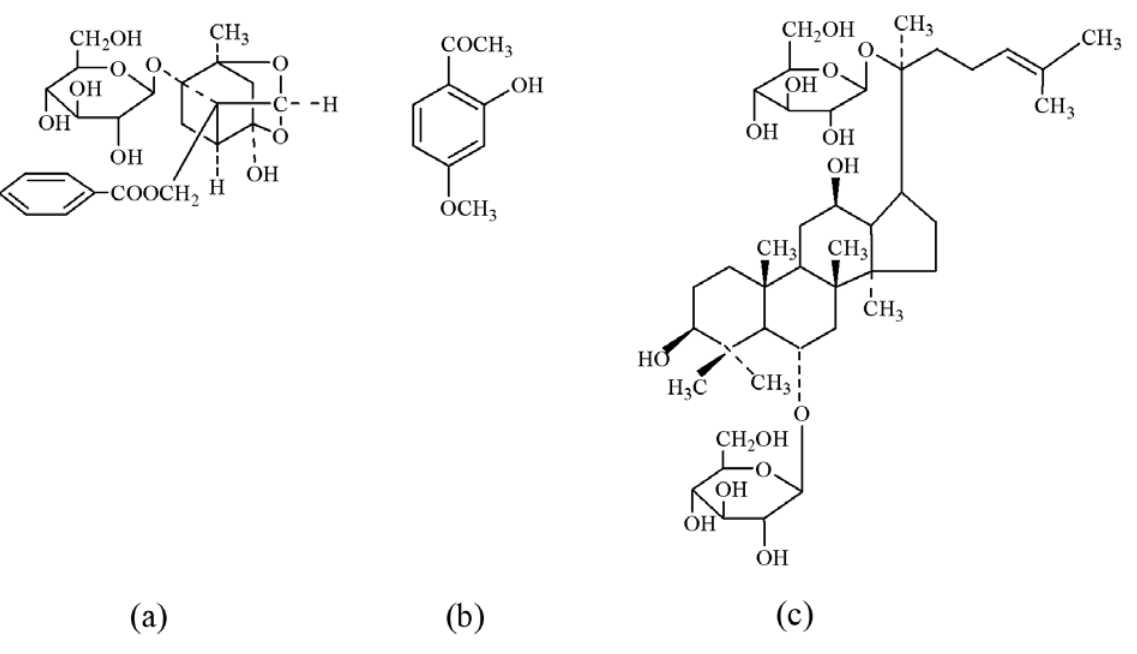
Fig. 1 Molecular structures of the analytes. (a) Paeoniforin, (b) Paeonol, (c) censenoside Rg 1